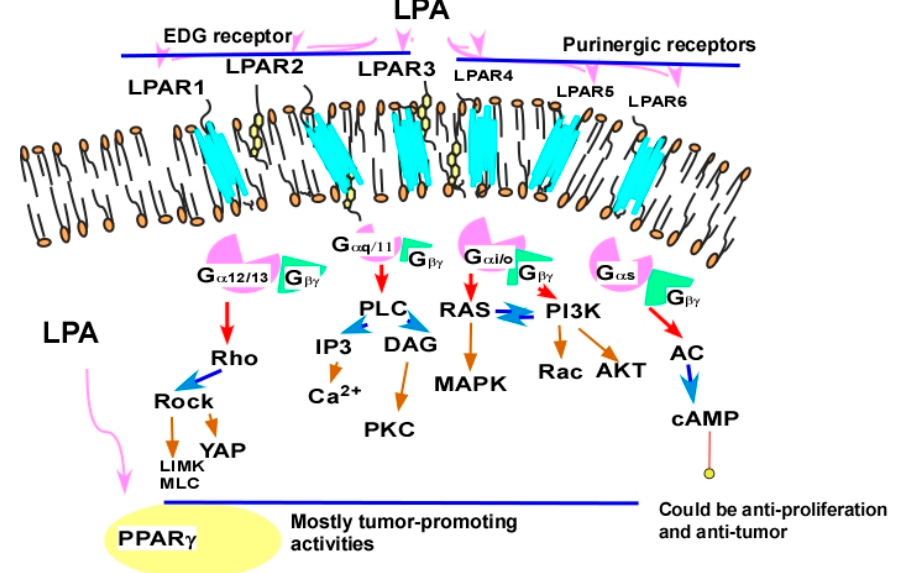
Figure 3. LPA receptors as targets. In general, the EDG family LPA receptors (LPAR 1–3 ) are coupled to G i , G q , and G 12/13 proteins [61,189] and are more involved in tumor-promoting activities. The purinergic family LPA receptors (LPAR 4–6 ) are all coupled to G 12/13 and other trimeric